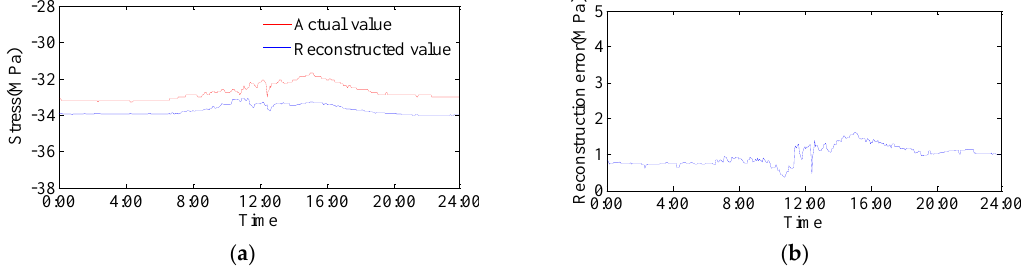
The contrast curves between reconstructed values and actual values are shown in Figure 5. The average absolute error is 0.97 MPa and the relative error is 2.97%.